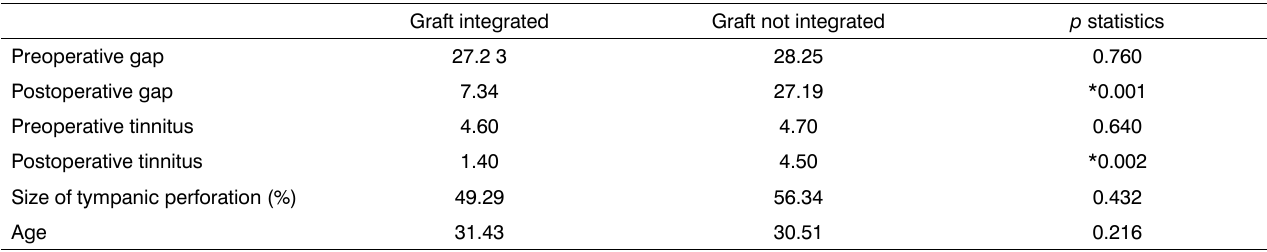
Table 1. Mean value of factors that may affect graft integration.